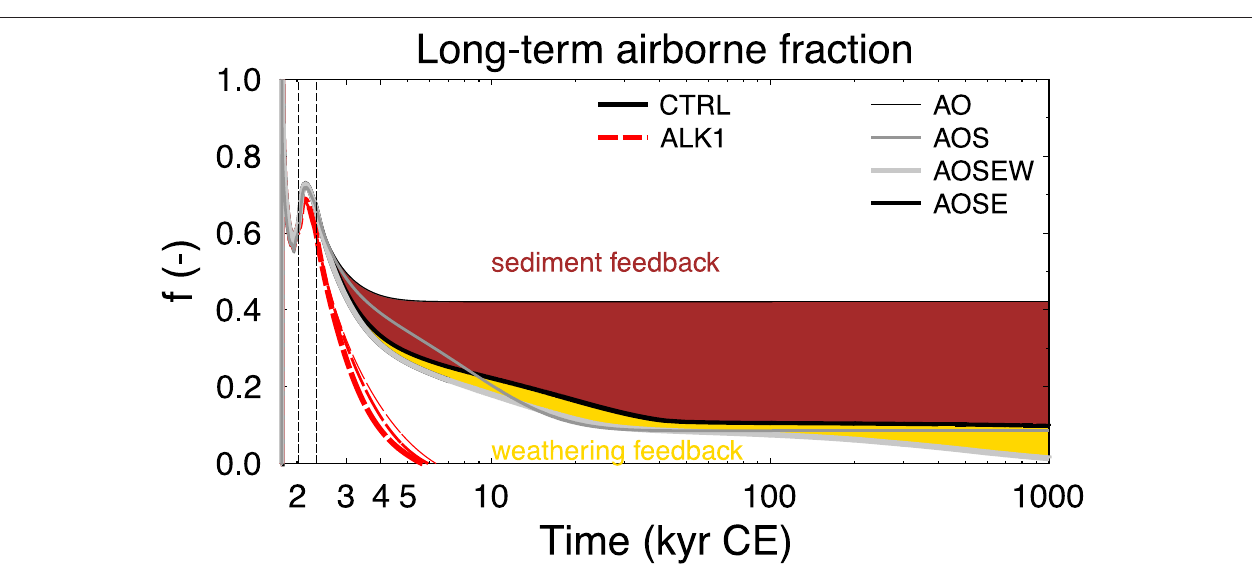
FIGURE 6 | Airborne fraction f of anthropogenic emissions for different model versions for up to 1,000 kyr CE (=1 Myr CE) in the CTRL run and alkalinization scenario ALK1. The color-coded areas show the CO 2 sequestration related to weathering and sediment feedback. Vertical lines are at 2020 CE (onset of alkalinization) and 2350 CE (emissions back to 0). Note log